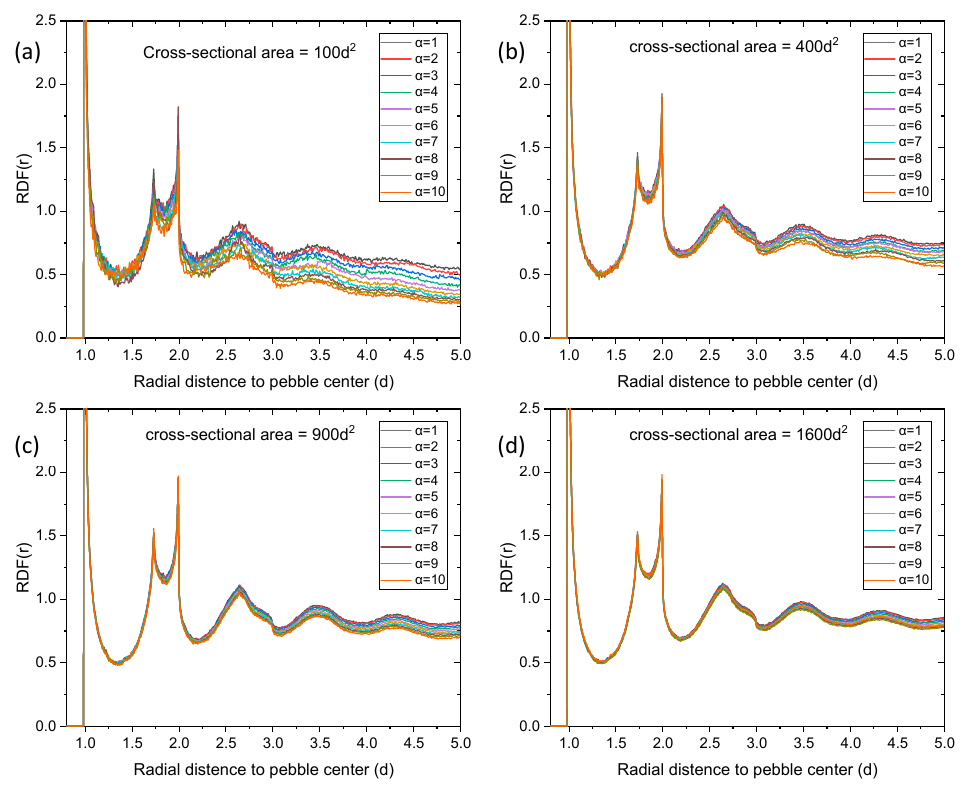
Figure 17. RDFs of the pebble beds with different aspect ratios α of 1–10 and cross-sectional areas of ( a ) 100 d 2 , ( b ) 400 d 2 , ( c ) 900 d 2 , ( d ) 1600 d 2 .